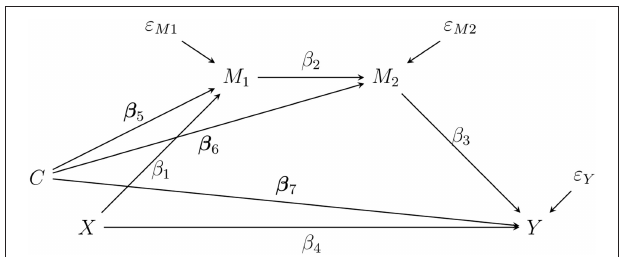
FIGURE 1 | A sequential two-mediator chain as a path diagram. The effect of X (Racist Profile vs Control) and Y (threat to gender identity) is transmitted through a sequence of mediators measured over time. Note that X should be measured before M 1 (social dominance orientation), M 1 should be measured before M 2 (perceived sexism), and M 2 should be measured before Y . C (liking) is a covariate. ε M 1 , ε M 2 , and ε Y are the residual terms.